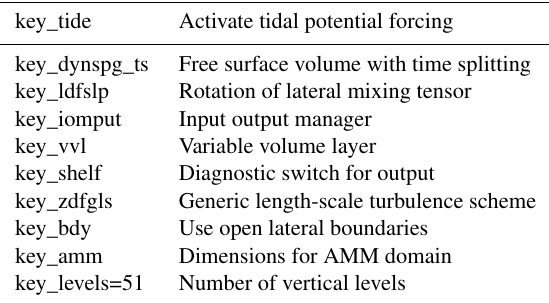
Table A1. FPP keys used with the CO5 control